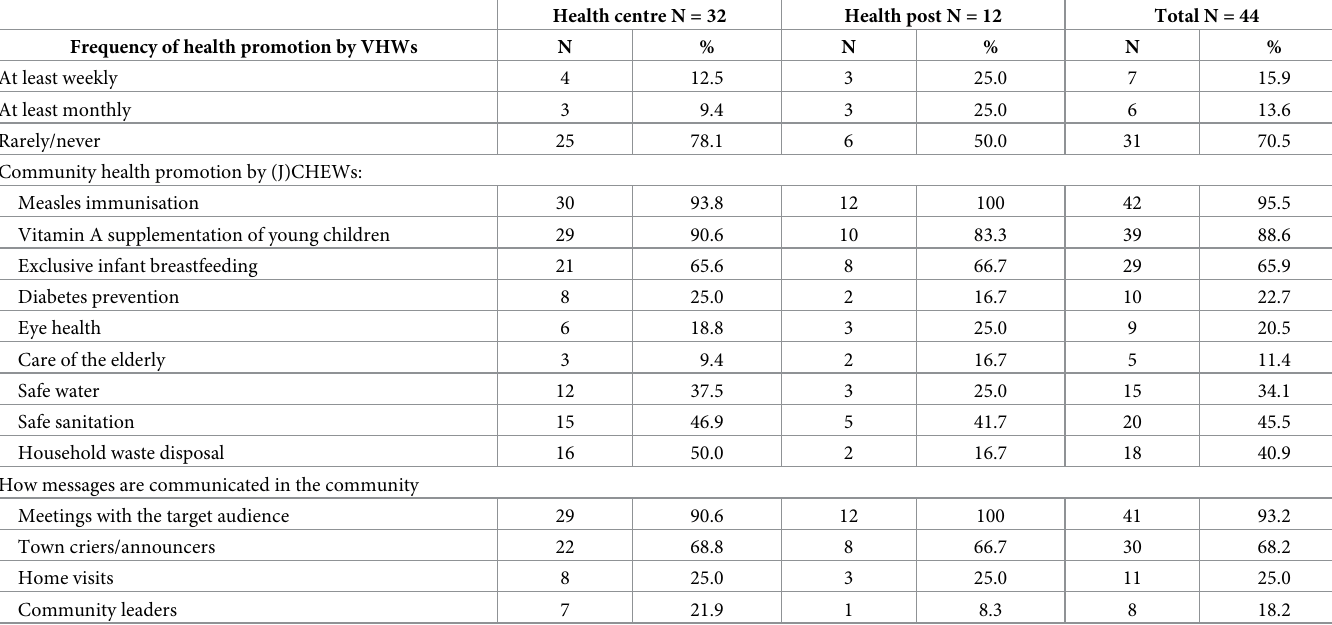
Table 3. Health promotion activities in the community described by facility